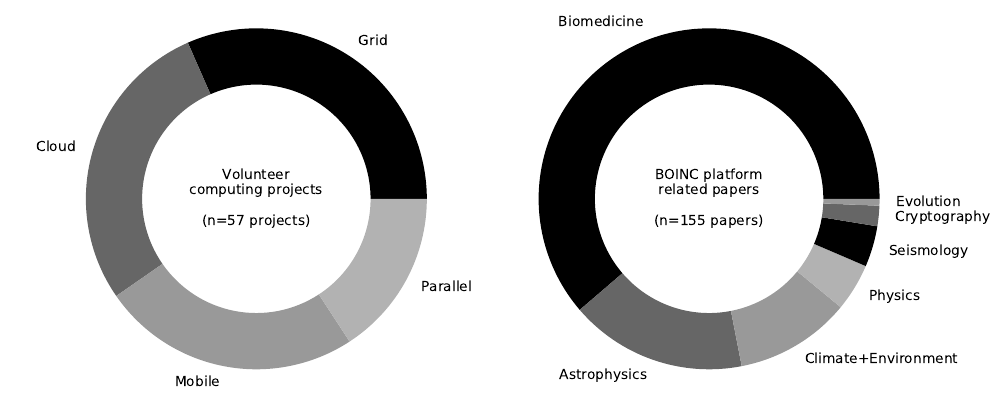
Figure 4. Categories and research disciplines of VC projects, data taken from